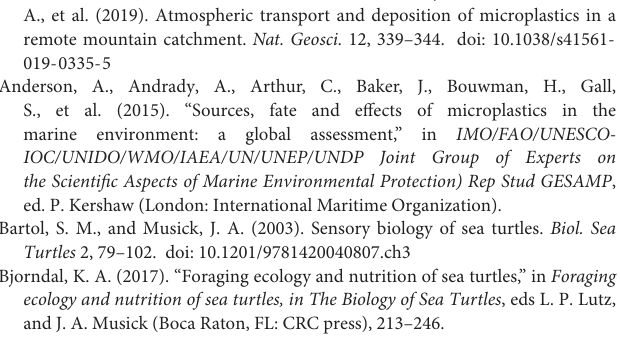
FIGURE S1 | (A) Map of the approximately 150 km stretch of north Florida coastline (Nassau County to Flagler County), over which the necropsied post- hatchlings stranded along. Map was modified from one generated by Eric Gaba (https://commons.wikimedia.org/wiki/File:USA_Florida_relief_location_map.jpg)